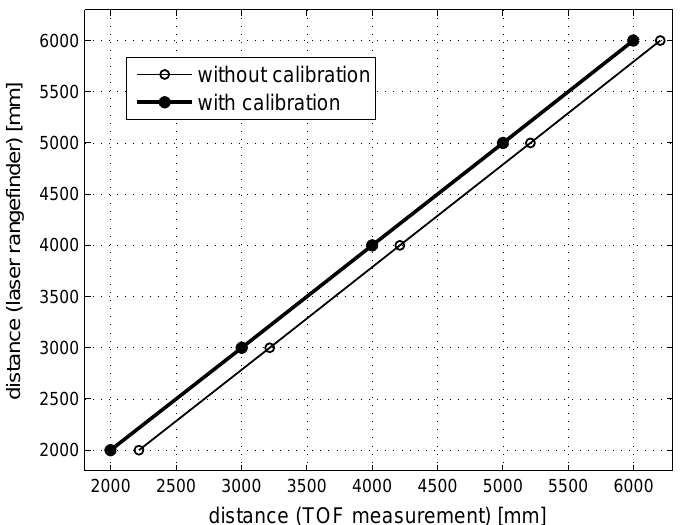
Figure 9. Calibration procedure for a pair of nodes. A linear regression of the distance measurements is used in order to compensate the group delay in the TOF measurements. The distances measured with the laser rangefinder are plotted on the Y-axis, while the averaged distances obtained from the TOF measurements are plotted on the X-axis. The thin line shows the linear regression of the plotted dots before the group delay compensation. Here a distance error of 22.41 cm is observed. The thick line shows the regression line obtained after calibration of the